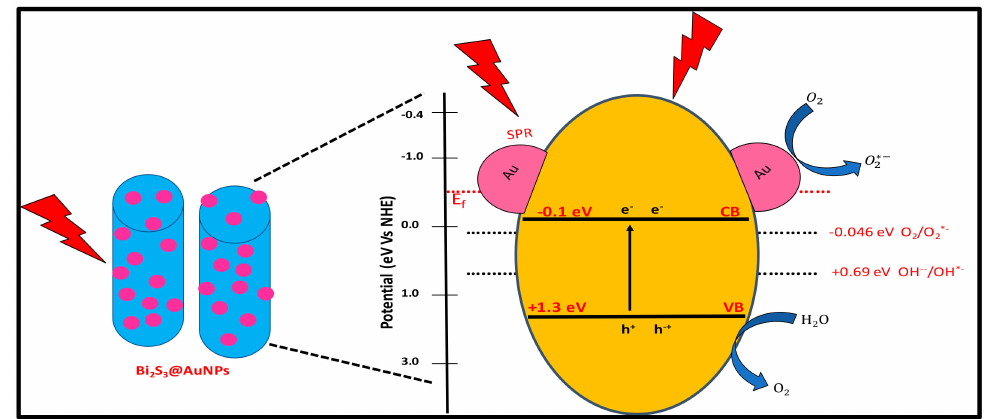
Figure 6. Schematic diagram showing possible photocatalytic degradation mechanism for the nanocomposites under visible-light